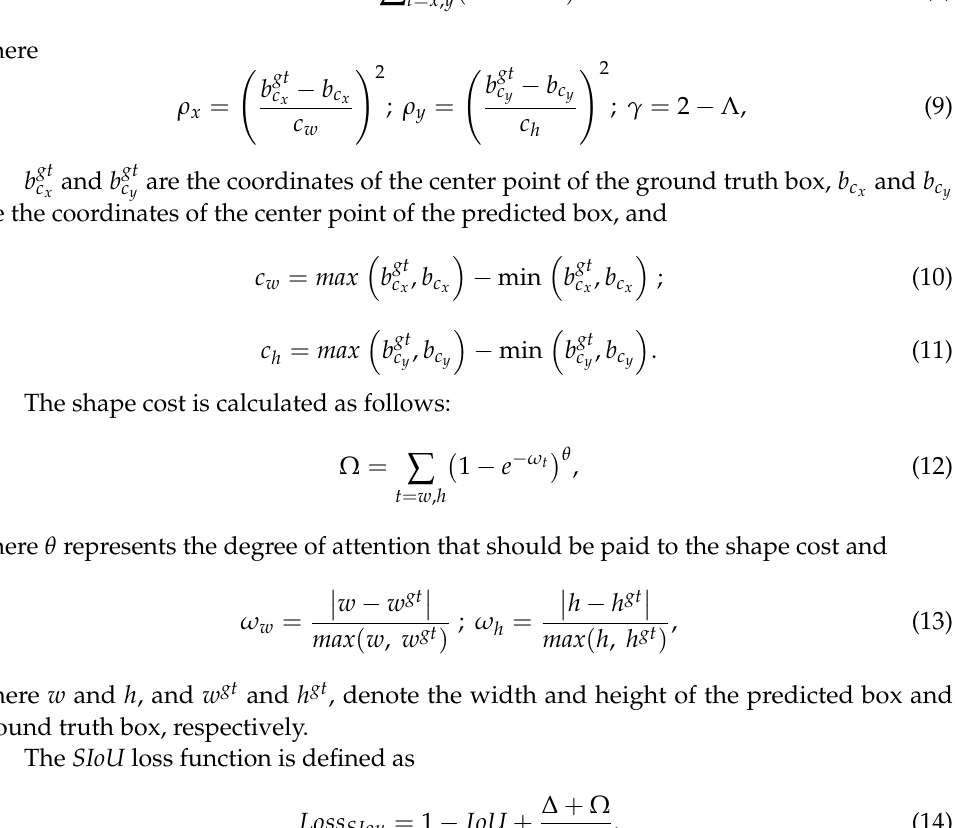
Figure 9. The YOLOv5_CBS structure.